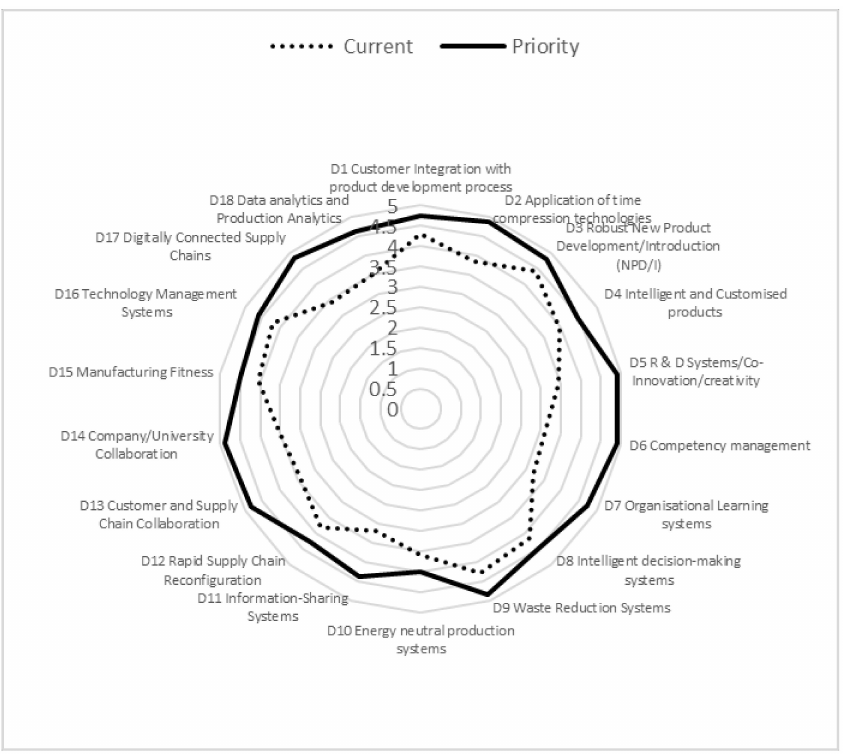
Figure 4. The analysis of current and future profiles of SMEs with 51–250